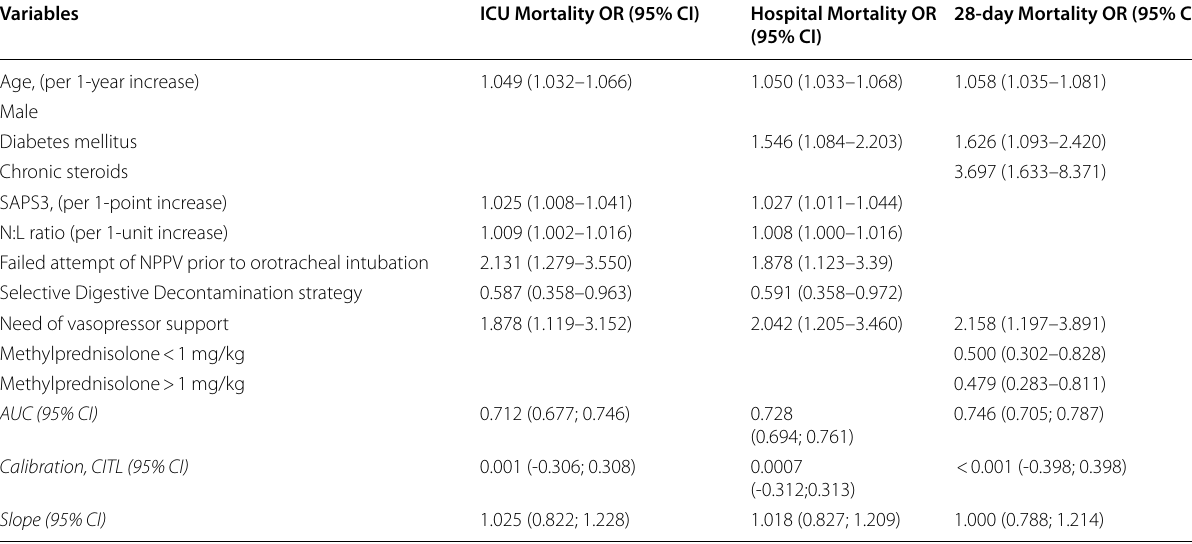
SAPS, Simplified Acute Physiology Score; NPPV: noninvasive positive pressure ventilation; N: L, neutrophil to lymphocyte ratio; AUC; area under the curve. OR, Odds Ratio; CI, confidence interval